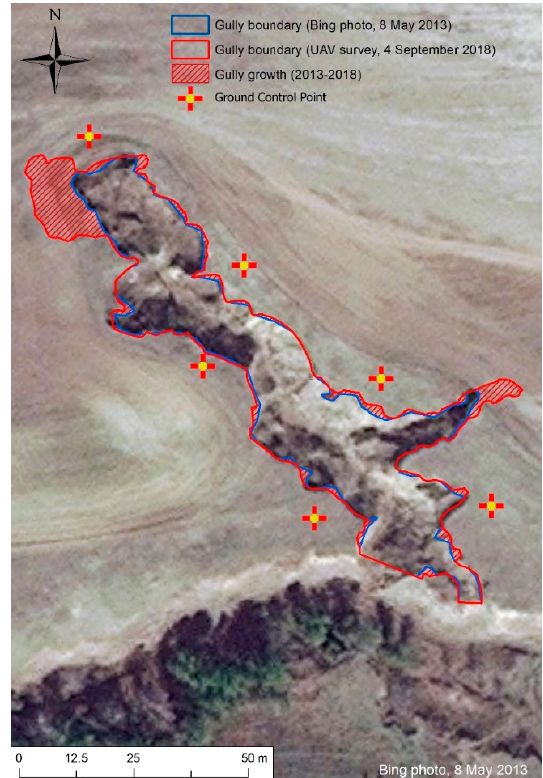
Figure 4. Schematic map of Bulanka gully change for 2013–2018. Table 1. Morphometric characteristics of the model section of the Bulanka